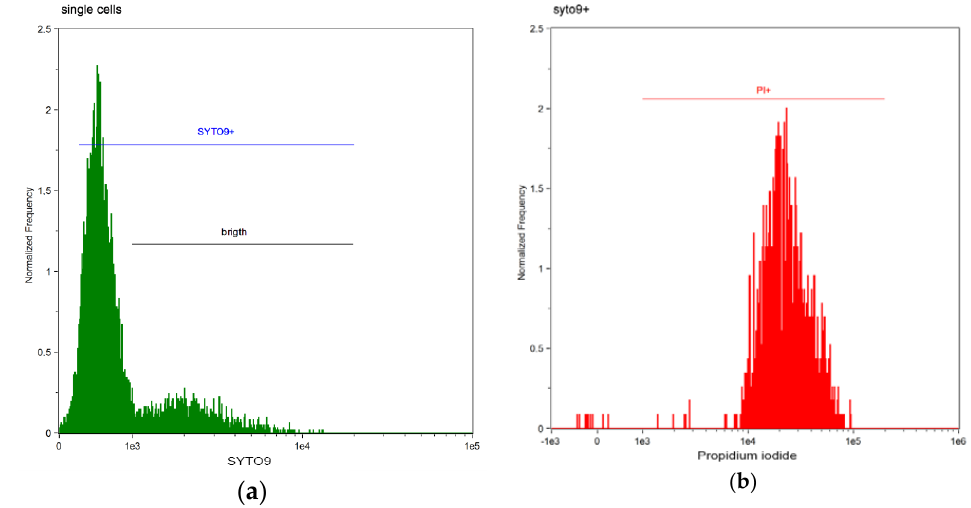
Figure 1. Flow cytometry analysis of E. faecalis cell-suspension after 60 min incubation with NaCl (a single experiment example). ( a ) Cells labelled green (SYTO9+); ( b ) Cells labelled red (PI).